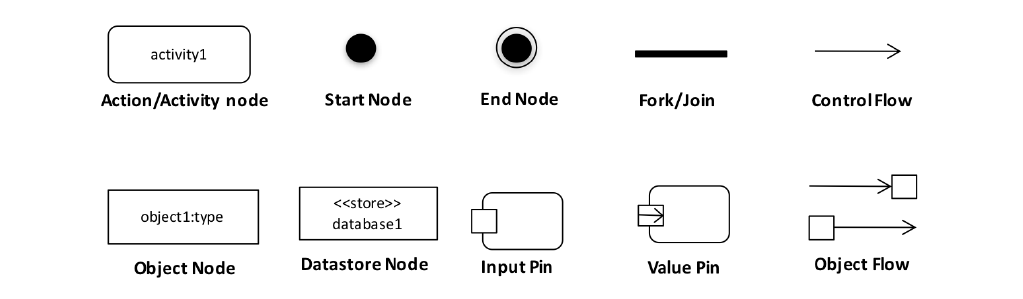
Table A2. UML Activity Diagram elements notation and